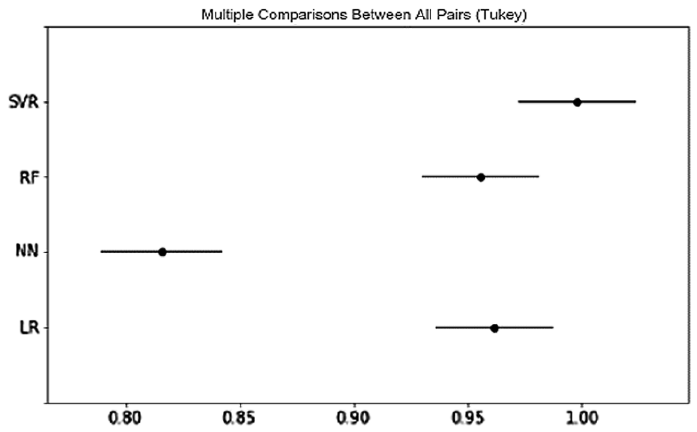
Figure 9. Multiple comparisons between all pairs (Tukey) in product categories for psychographic segmentation-based rating explaining (R 2 ).